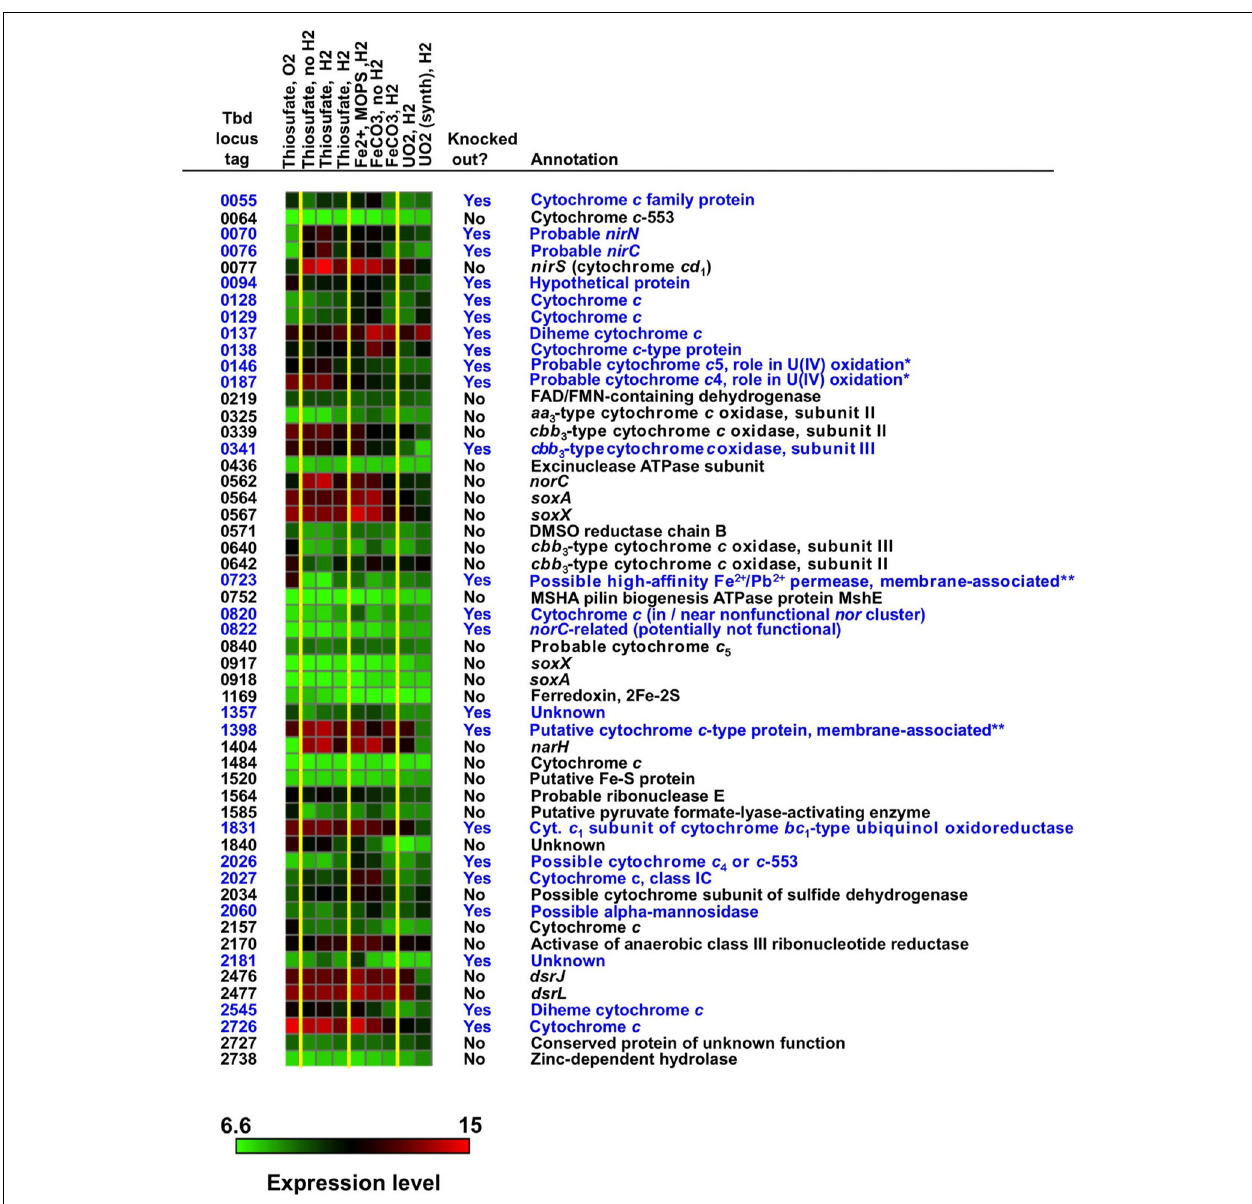
An intensity color scale is shown.To provide some perspective for the intensity scale, the following are the average percentile values for intensity for all genes on all arrays: 50th percentile = 8.0, 75th percentile = 9.0, 90th percentile = 10.4, 95th percentile = 11.3, and 100th percentile = 15.1.The symbol “*” represents genes previously shown to be associated with nitrate-dependent U(IV) oxidation (Beller etal., 2009) and “**” represents genes encoding proteins that were experimentally shown to be membrane associated (see